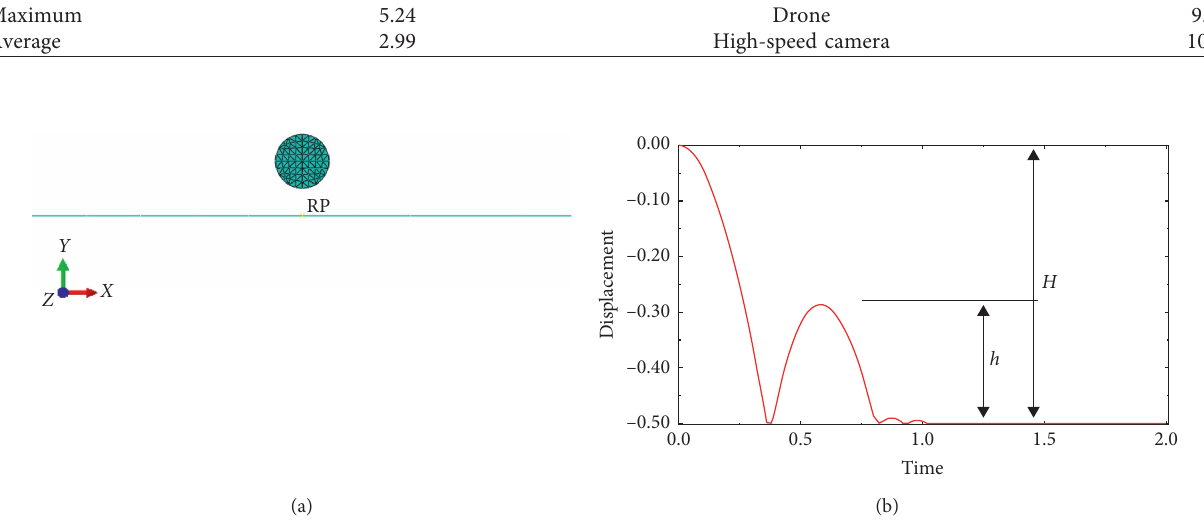
Figure 4: Simulation of the pendulum test: (a) mesh for simulation; (b) result of simulation.